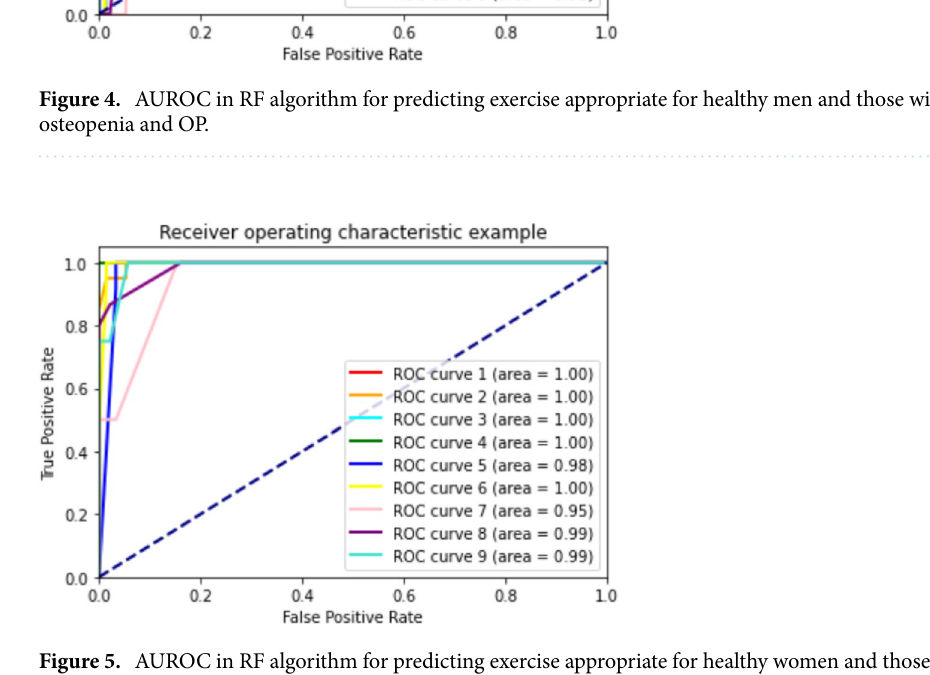
Figure 5. AUROC in RF algorithm for predicting exercise appropriate for healthy women and those with osteopenia and